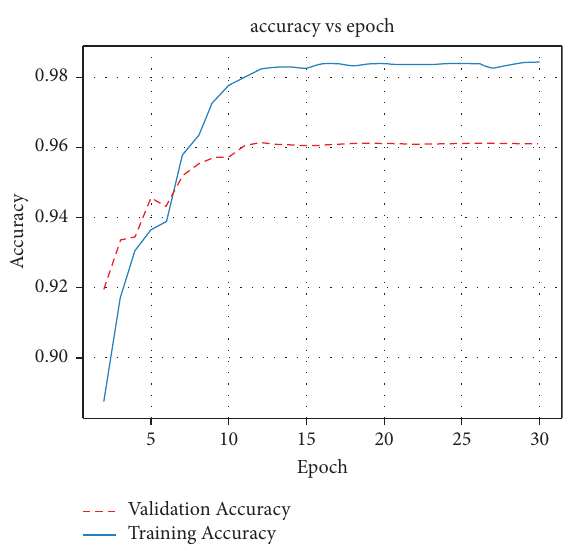
Figure 11: Observed accuracy for case